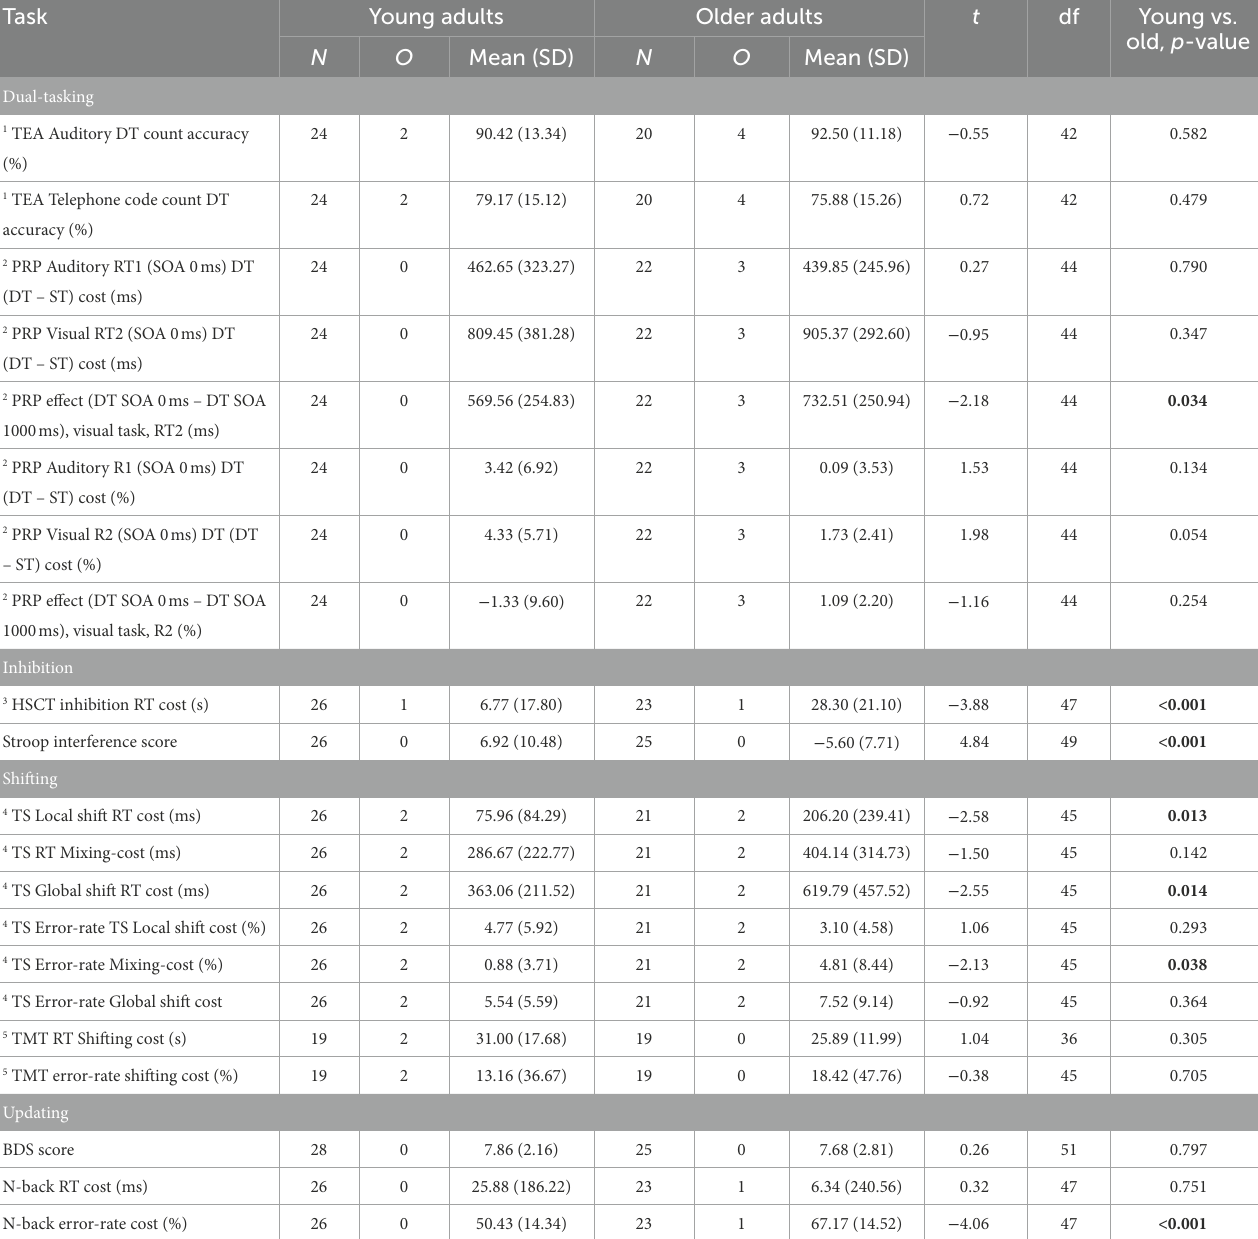
TABLE 2 Executive function abilities: cross-sectional analysis between the young and older adults.